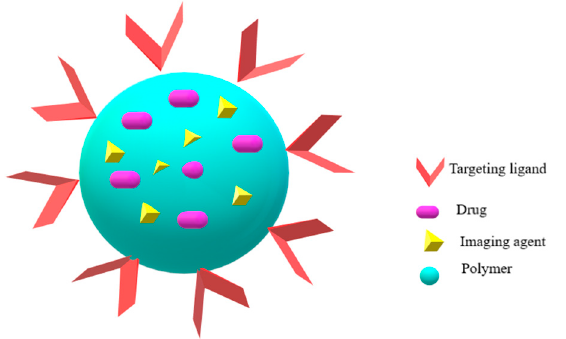
Figure 5. Chitosan NPs as